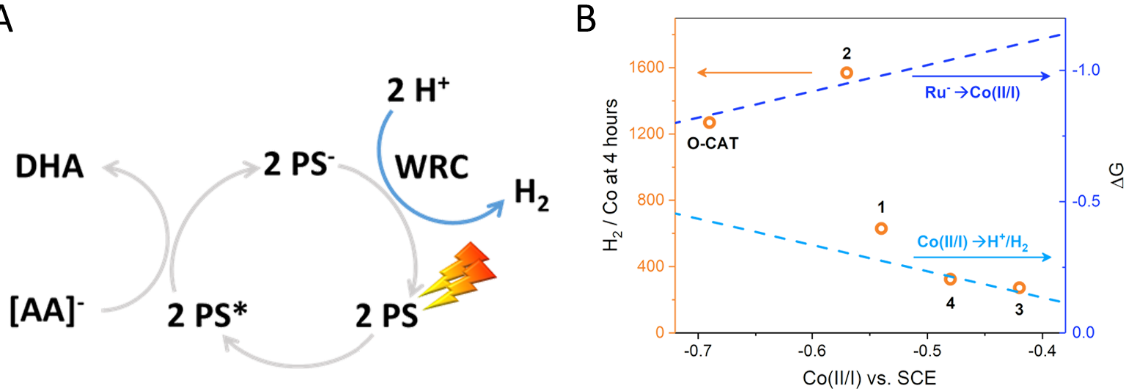
Figure 5. Mechanistic analysis of H 2 photocatalysis by O-CAT and 1 – 4 . ( A ) Proposed photocatalytic cycle through reductive quenching of photosensitizer excited state (PS*) by deprotonated ascorbic acid (AA − ). DHA = dehydroascorbic acid; WRC = water reduction catalyst. ( B ) Plot of H 2 turnovers (TON) vs. Co(II/I) reduction potential (left axis) and overlay of ΔG from reduced PS to Co(II) and Co(II/I) to H + /H 2 .